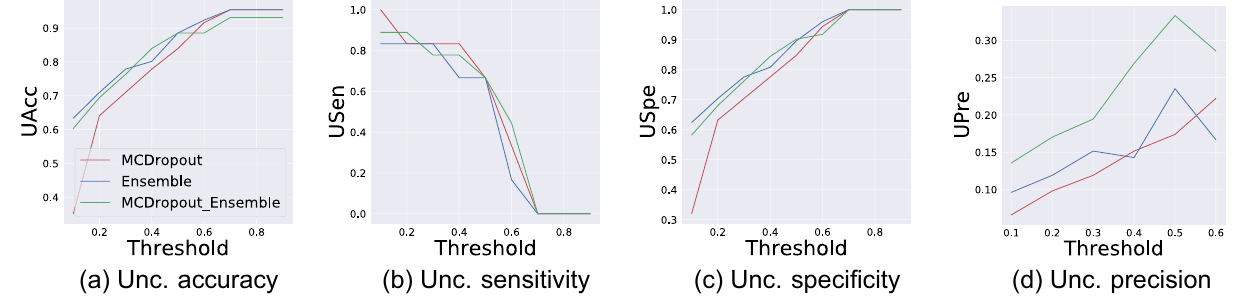
Figure 6. Quantitative evaluation of three uncertainty quantification techniques using performance metrics introduced in section “Predictive uncertainty evaluation”. Uncertainty accuracy, sensitivity, specificity, and prediction are calulated for threshold values between 0.1 and